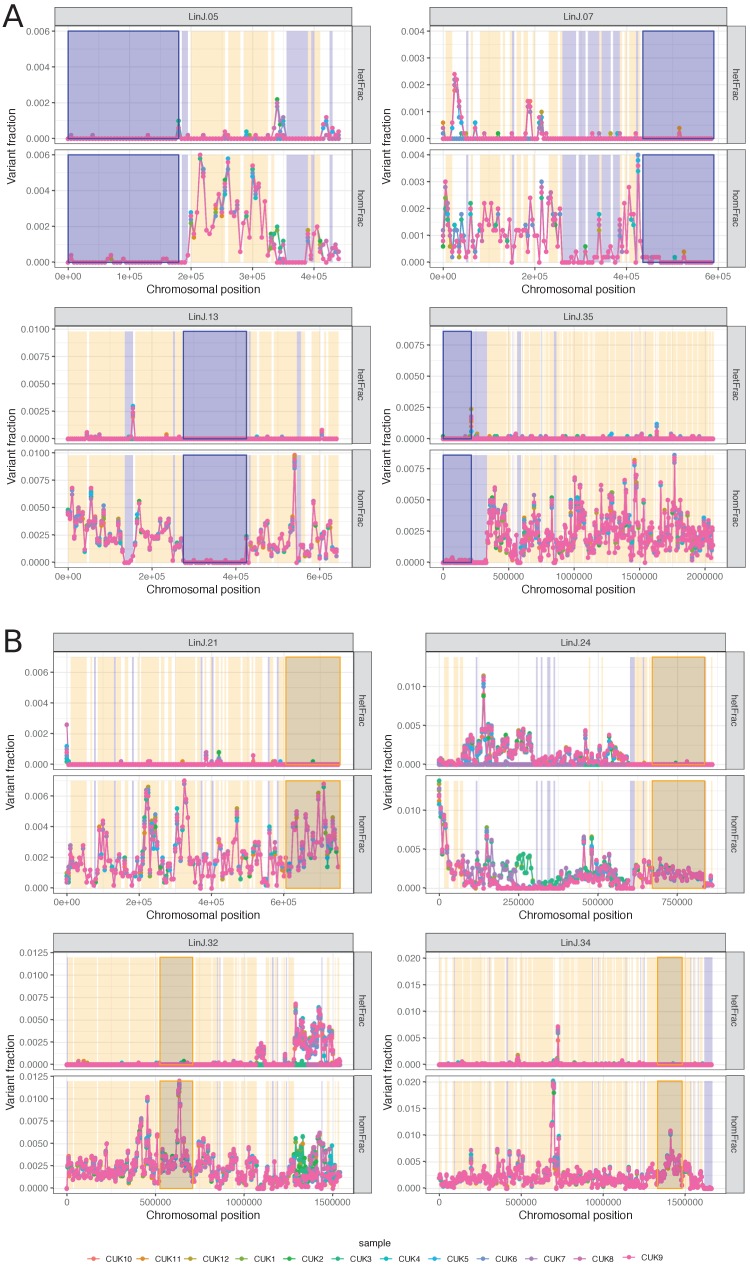
Genomic regions used for haplotype-based parent identification.Figures show the four largest identified genomic regions specific to either parent used for parent characterisation: (A) JPCM5-like parent and (B) other unknown parent. Each figure shows the fractions of heterozygote SNPs or fixed homozygous SNPs with respect to the JPCM5 reference for each of the 12 isolates from the Cukurova region, Turkey (CUK, Rogers et al., 2014). Conservatively called regions originating from a specific parent are coloured in blue (JPCM5-like) and orange (other). Genomic regions used for phylogenetic reconstruction are framed.